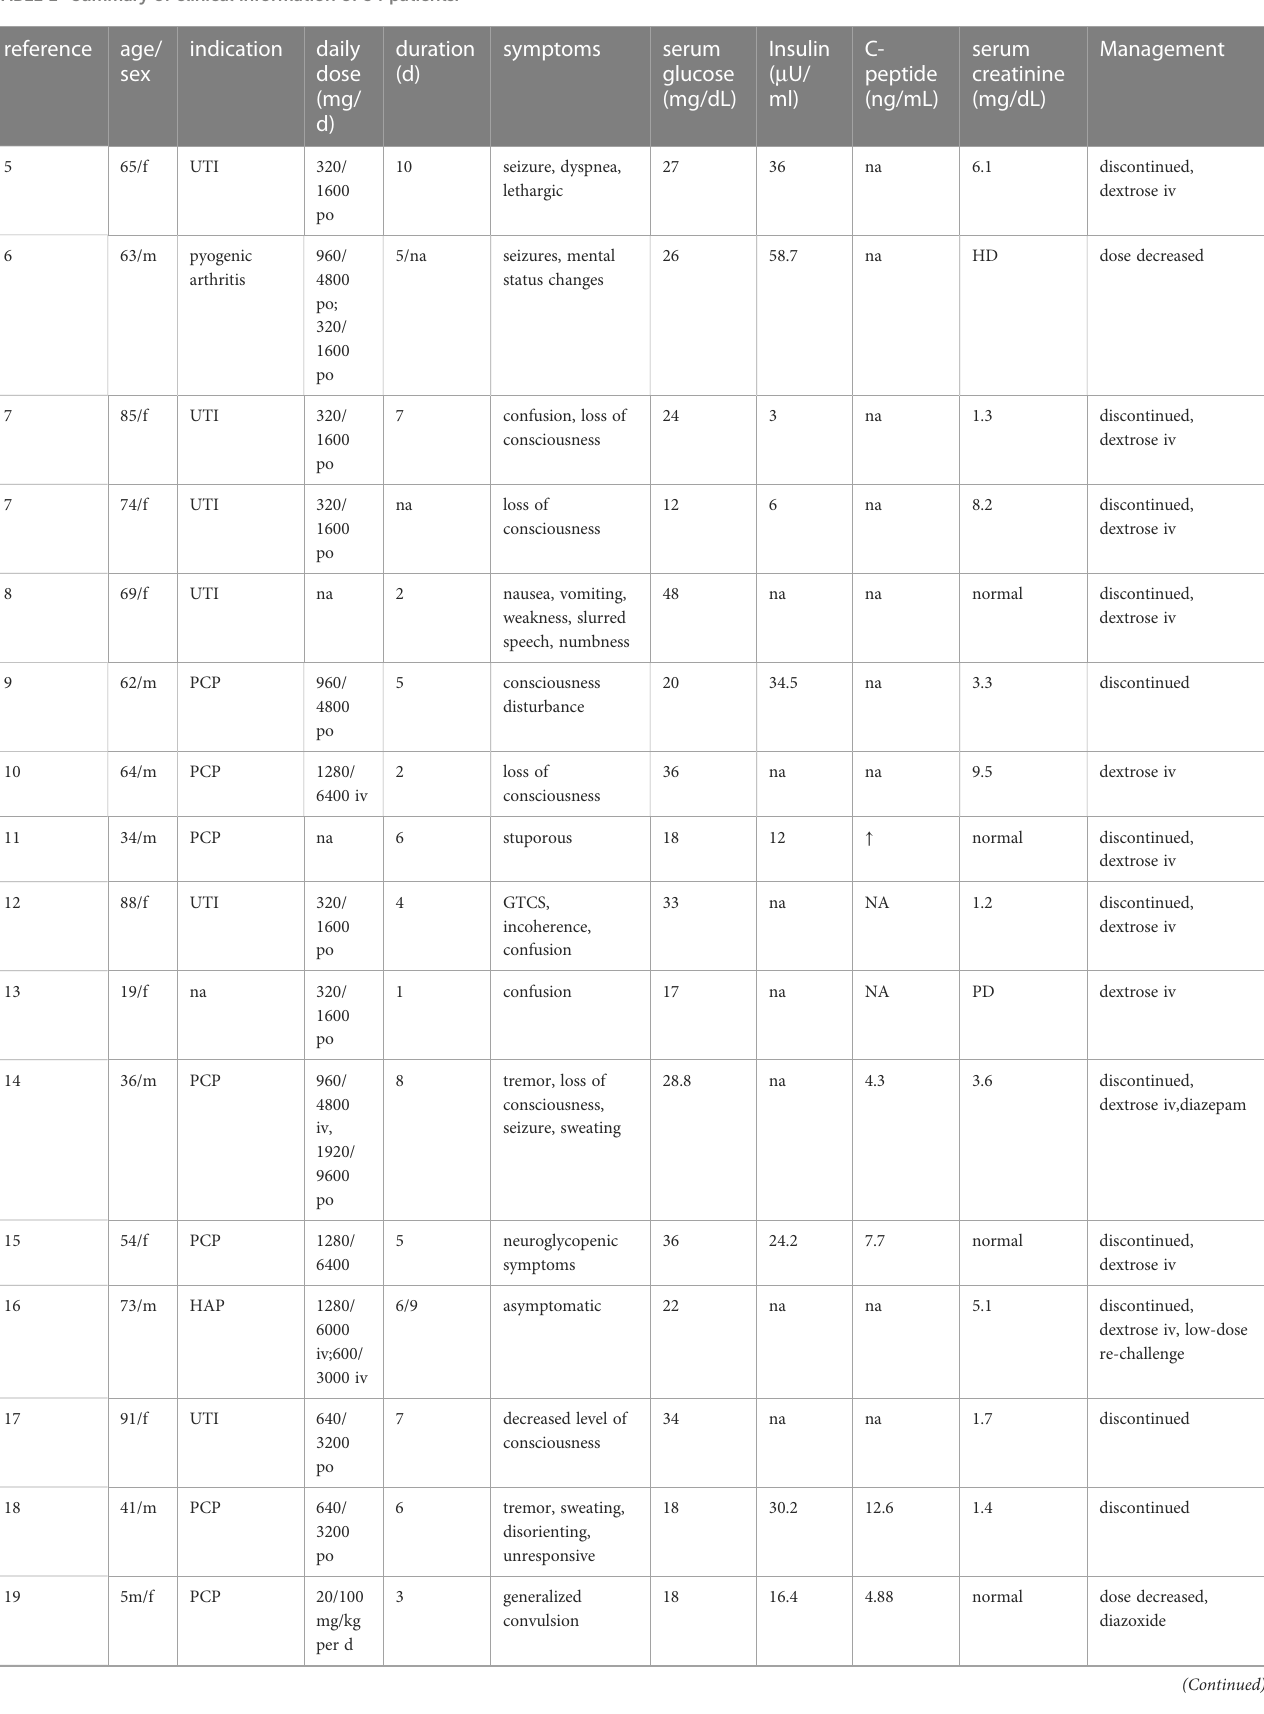
TABLE 1 Summary of clinical information of 34 patients.